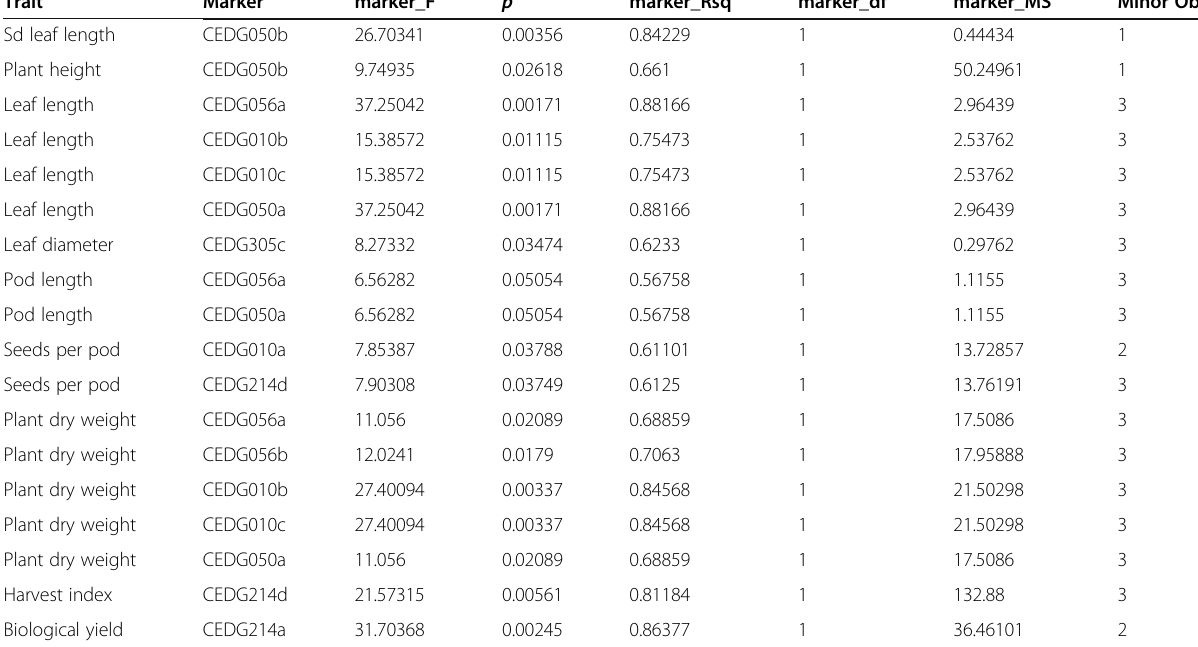
Table 9 Association of SSR markers with single agronomic trait of 7 Vigna radiata genotypes Trait